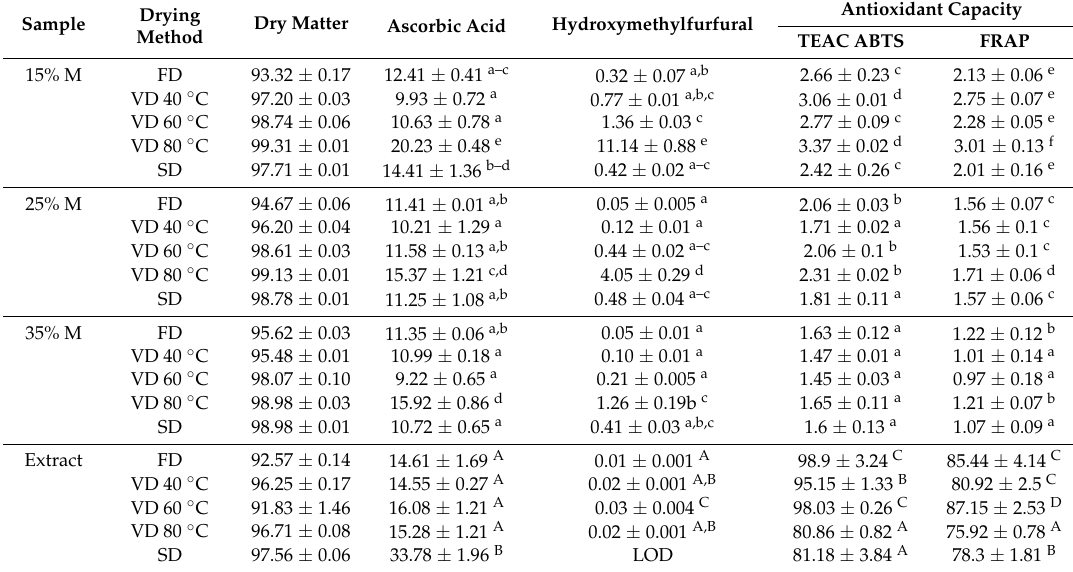
Table 3. The dry matter (%), content of vitamin C (mg · 100 g − 1 db), 5-hydroxymethylfurfural